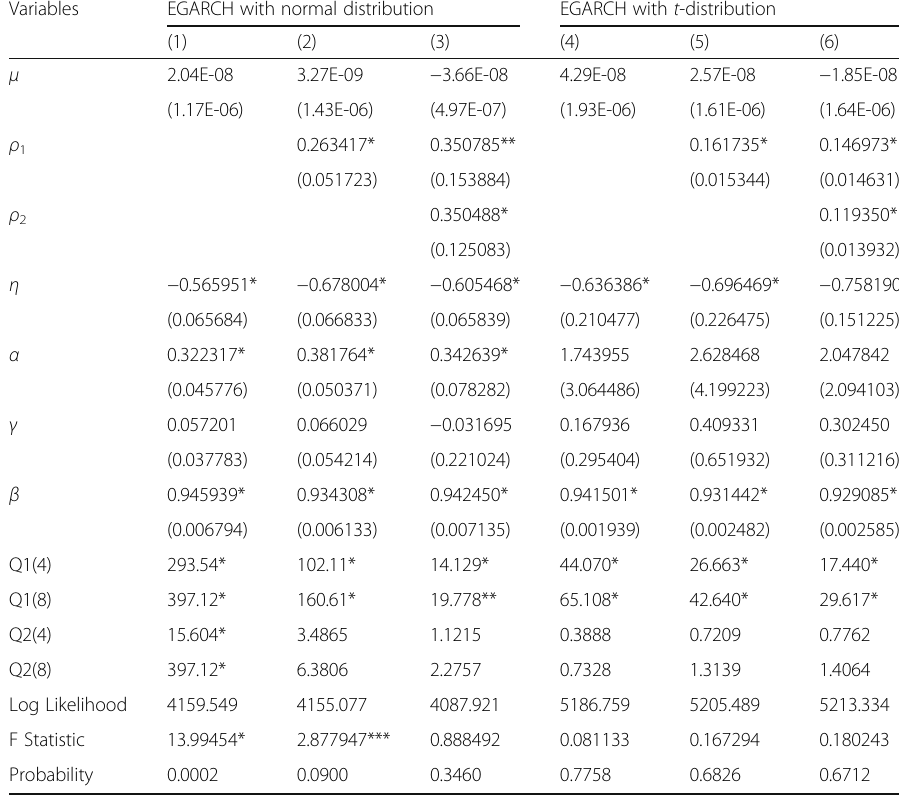
Table 4 Estimation results for EGARCH model Variables EGARCH with normal distribution EGARCH with t